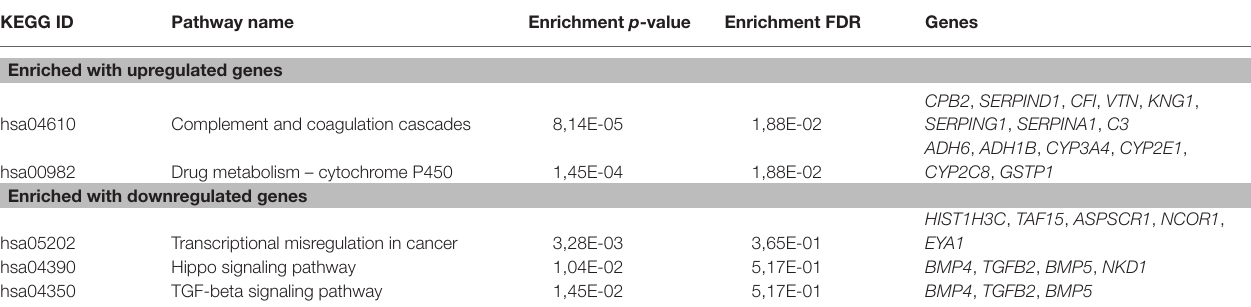
TABLE 2 | KEGG pathways that are significantly enriched with genes associated with PFS in castration-resistant prostate cancer